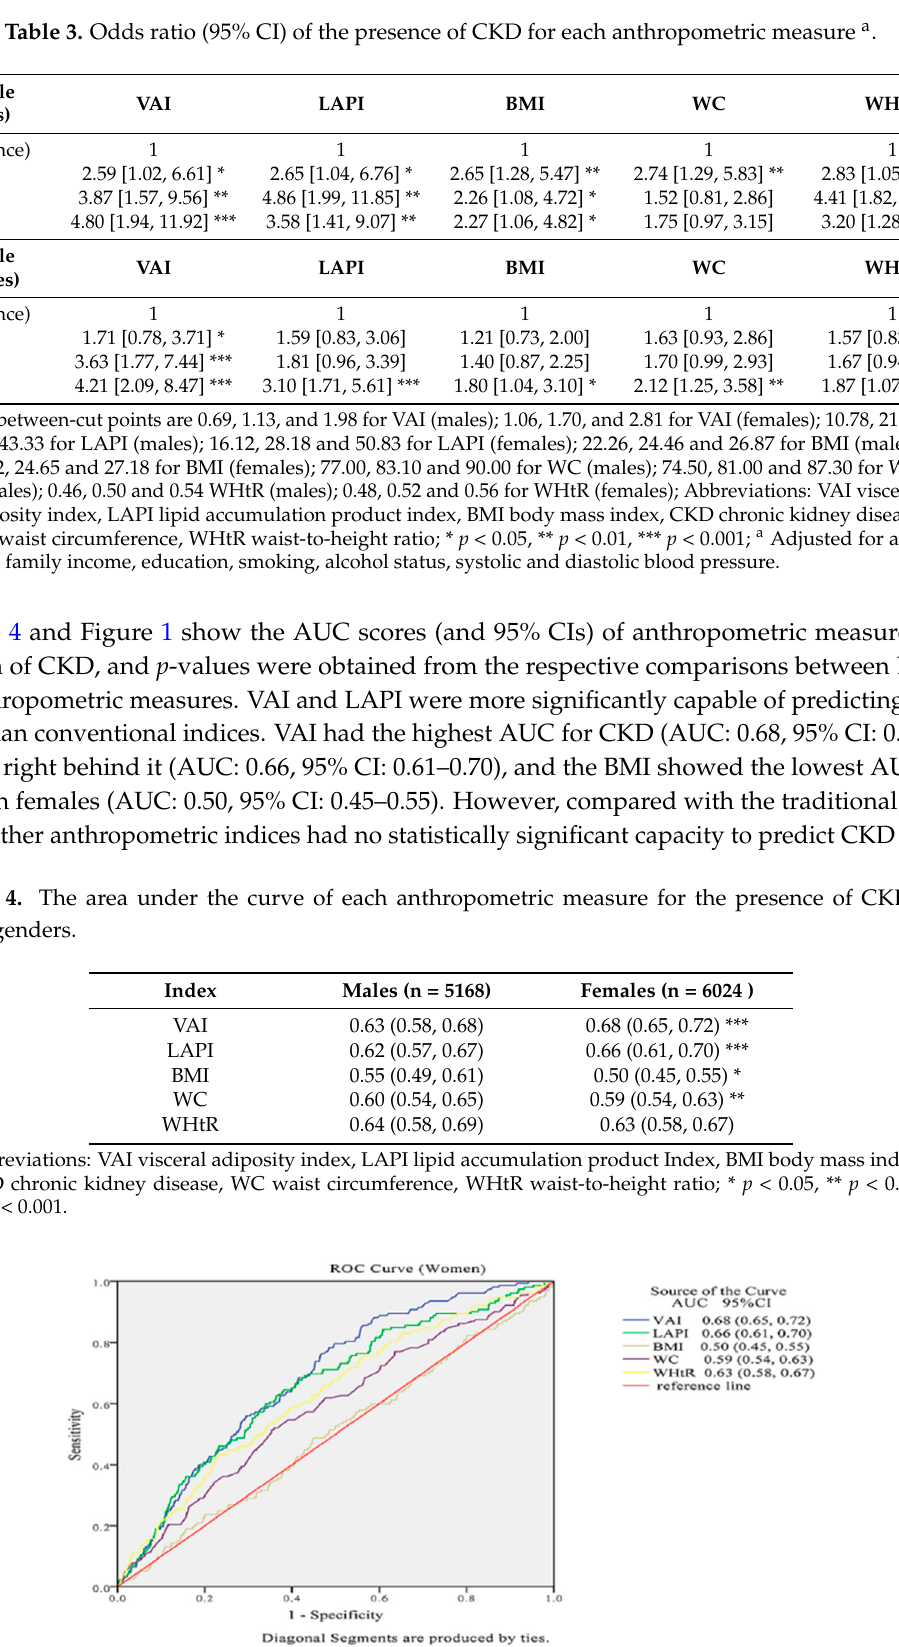
Figure 1. The discriminatory power of VAI, LAPI, BMI, WC and WHtR between subjects with or without CKD. Area under the receiver operating characteristic curve of VAI, LAPI, BMI, WC and WHtR to identify subjects with CKD according to sex. 4. Discussion The main finding of this cross-sectional study was that all anthropometric indices (VAI, LAPI, BMI, WC, and WHtR) were significantly associated with CKD (eGFR <60 mL/min per 1.73 m 2 ) among rural populations in northeast China. To our knowledge, there has been no relevant literature confirming a significant association between LAPI and CKD so far. Our study has found for the first time that the LAPI had a positive correlation with CKD. Moreover, there are few relevant studies to compare the relative strength of the association between comprehensive obesity measurements and CKD, and the predictive power of traditional indices for chronic diseases is still controversial. Our study showed for the first time that VAI and LAPI had superior predictive ability for identifying CKD as compared to traditional indices in women, and BMI did not effectively predict the existence of CKD. Neither VAI nor LAPI had obvious advantageous capabilities for identifying the association between obesity and CKD compared to BMI in the male gender, while our study indicated that the two surrogate anthropometric indices VAI and LAPI were more suitable for identifying CKD in women. Although there were several epidemiologic studies showing that obesity and CKD have increased in parallel worldwide and are positively correlated [30], the mechanisms by which changes in adiposity affect CKD are not entirely clear. Henegar JR and his colleagues conducted force-fed dog studies which showed a significant increase in kidney weight, plasma renin activity and insulin concentrations in obese dogs compared with lean dogs. These early hemodynamic and structural changes in kidney function could be influenced by a high-fat diet [31]. Moreover, some recent works proposed that obesity-related subclinical inflammation and oxidative stress could precede some changes in